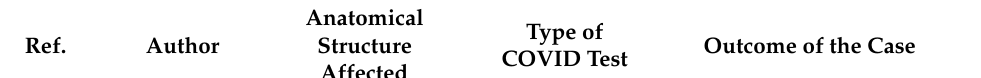
Table 2. Summary of case reports presented in the